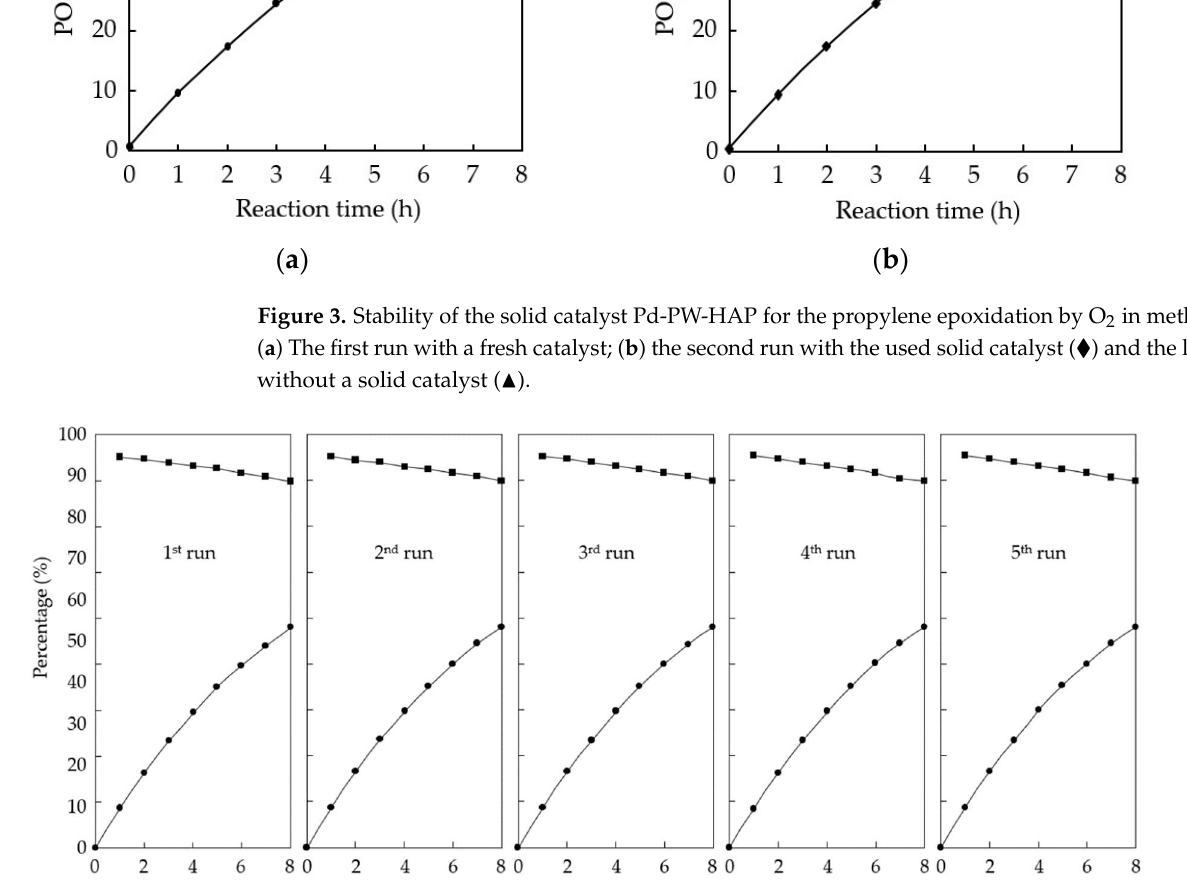
Figure 3. Stability of the solid catalyst Pd-PW-HAP for the propylene epoxidation by O 2 in metha- nol. ( a ) The first run with a fresh catalyst; ( b ) the second run with the used solid catalyst ( ♦ ) and the liquid without a solid catalyst ( ▲ ).